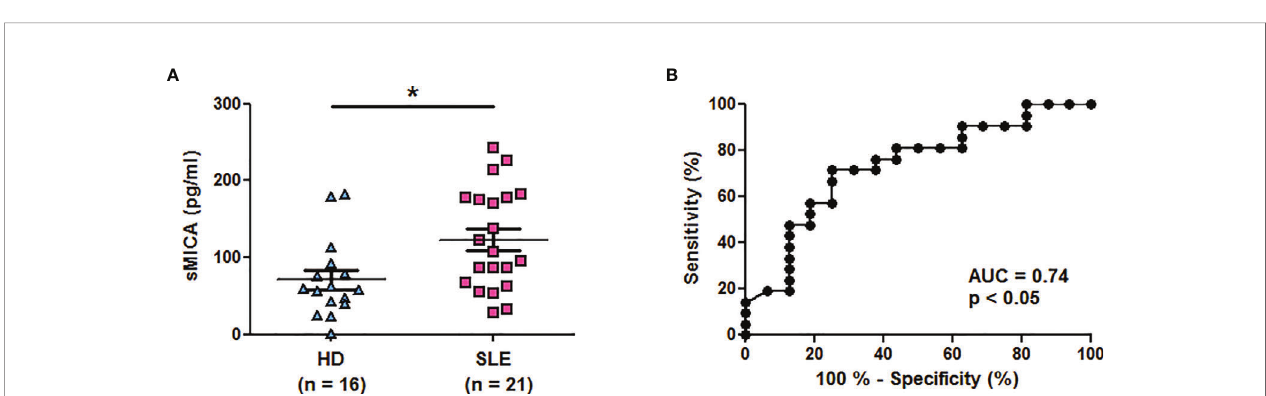
FIGURE 2 | Higher plasma concentrations of soluble MICA in SLE patients in comparison to healthy individuals. (A) Plasma concentrations of sMICA have been determined by ELISA. Each dot represents an independent donor. HD, healthy donors; SLE, systemic lupus erythematosus. Mean and SEM of all donors are shown. *p < 0.05 (two-tailed Mann Whitney test). (B) ROC curve illustrating the power of sMICA for discrimination between SLE patients and healthy individuals. AUC, area under the